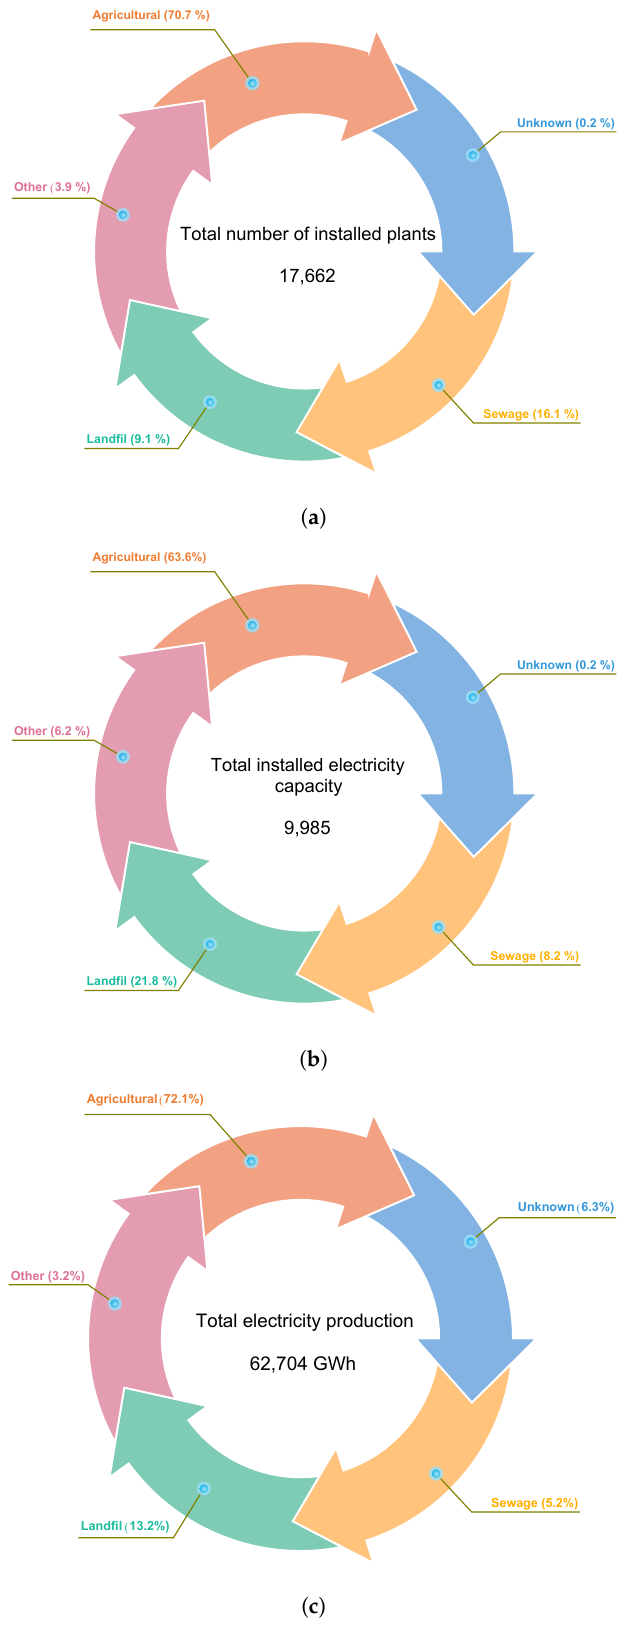
Figure 6. ( a ) Number of biogas plants per feedstock, ( b ) Installed electricity capacity per feedstock and ( c ) Electricity generation per feedstock in 2016. Data from: Reference